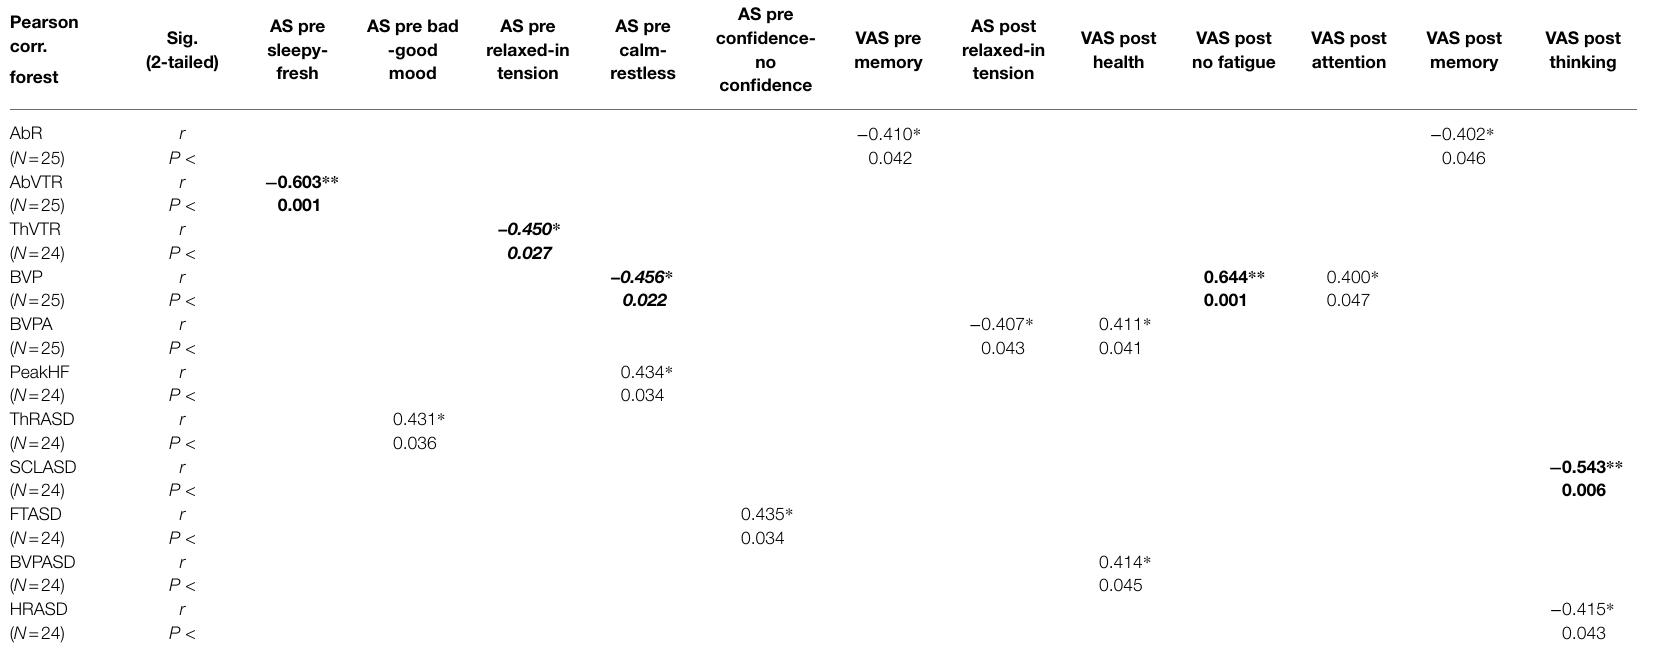
TABLE 5 | Pearson correlations between the (pre and post) evaluations of forest sounds and physiological functions. Pearson corr.